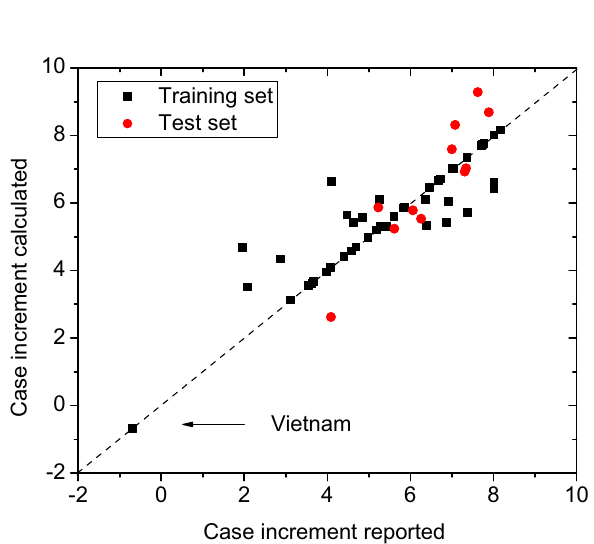
Figure 2. Relationships between the predicted and reported prevalence rates (generated by the OriginPro 8.5.0 SR1 software—http:// www. Origi nLab.